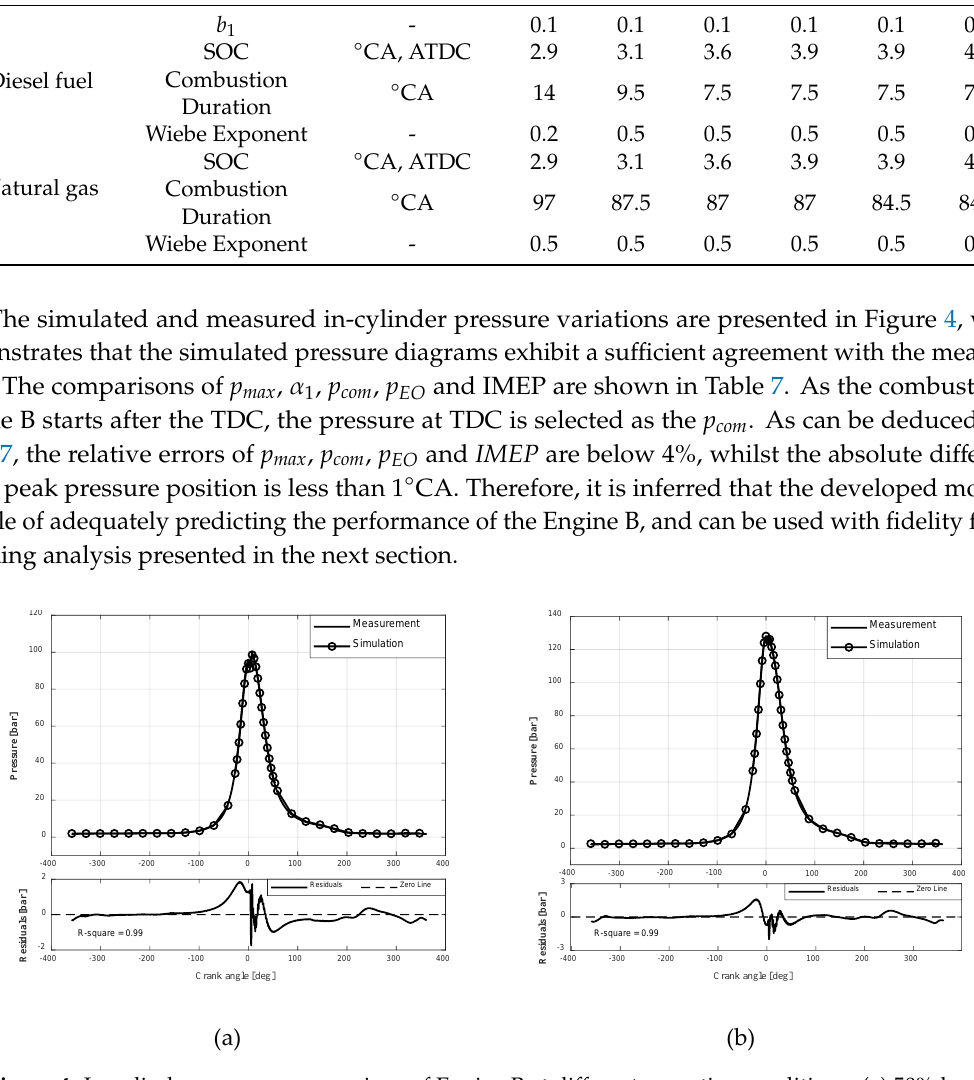
Figure 4. In-cylinder pressure comparison of Engine B at different operation conditions: ( a ) 50% load; ( b ) 85% load.